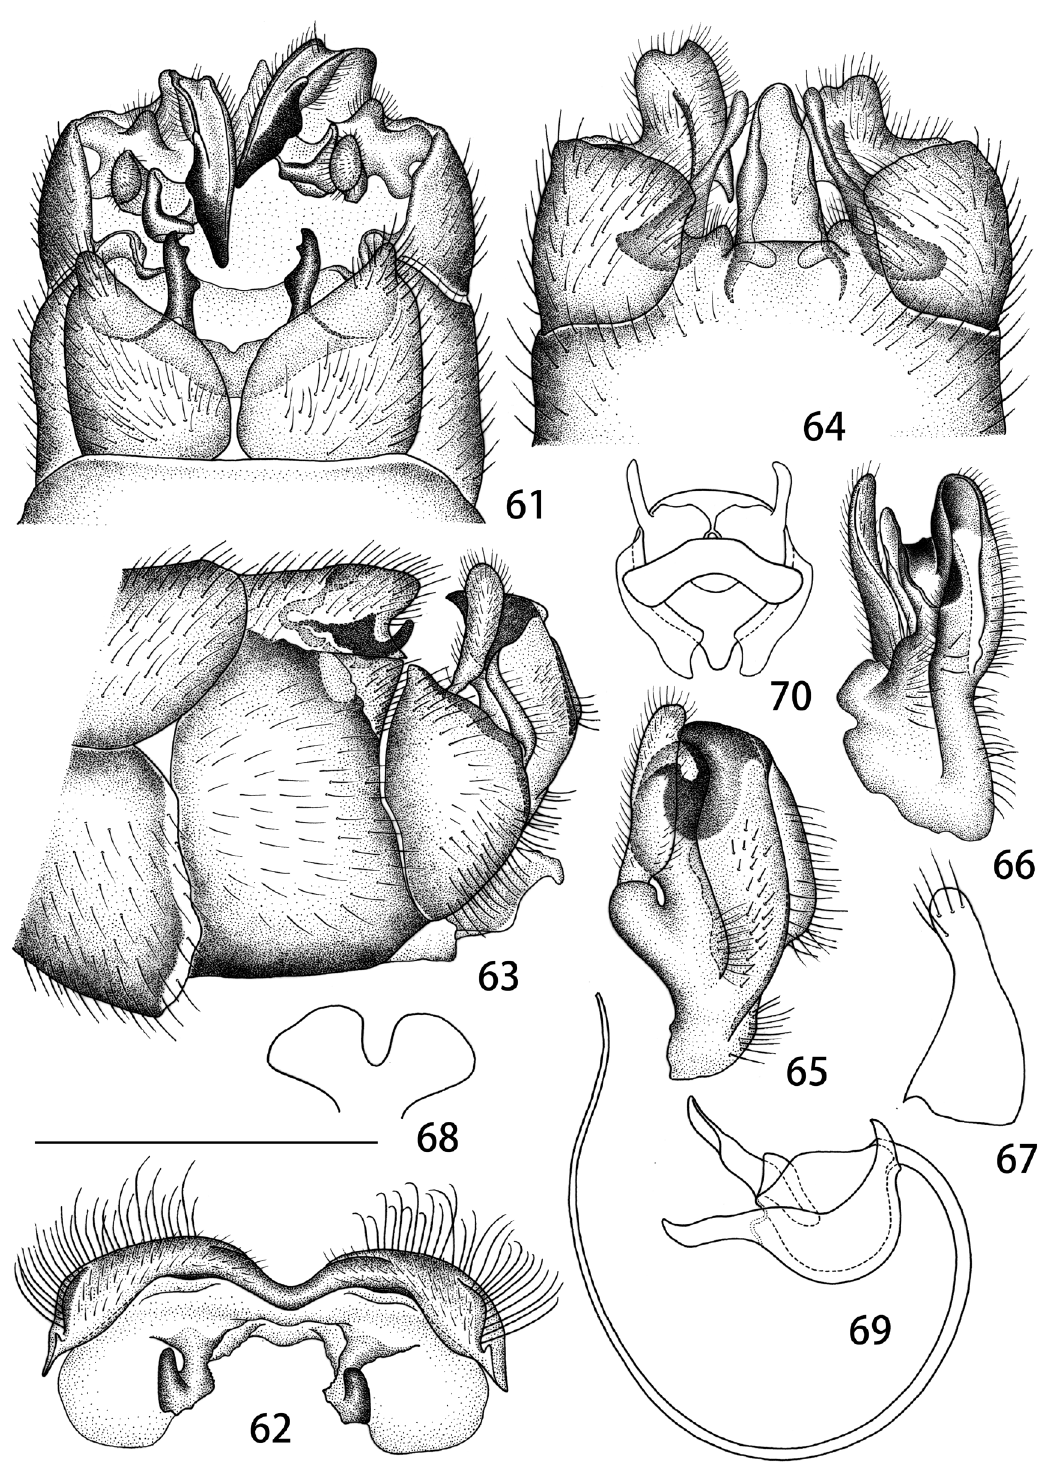
Figs 61–70. Tipula ( Vestiplex ) nestor Alexander, 1934, ♂, AQNU. 61 . Hypopygium, dorsal view. 62 . Tergite nine, ventral view. 63 . Hypopygium, lateral view. 64 . Hypopygium, ventral view. 65 . Left lobe and clasper of gonostylus, lateral view. 66 . Left lobe and clasper of gonostylus, dorsal view. 67 . Dorsal lobe of A9S. 68 . Ejaculatory apodeme of semen pump. 69 . Semen pump, lateral view. 70 . Semen pump, dorsal view. Scale bars: 61–64 = 1.0 mm; 65–67 = 0.7 mm; 68–70 = 1.0